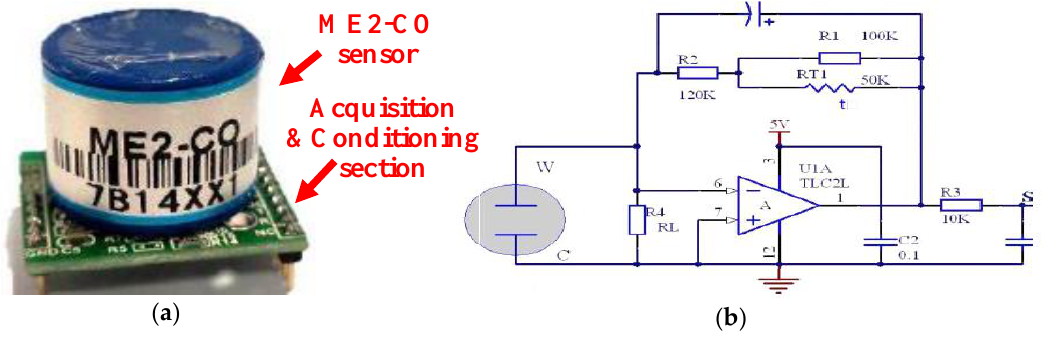
Figure 10. ZE07-CO module constituted by the ME2-CO sensor and the relative acquisition and conditioning section ( a ), potentiostatic circuit included on the ZE07-CO acquisition and conditioning board ( b ).